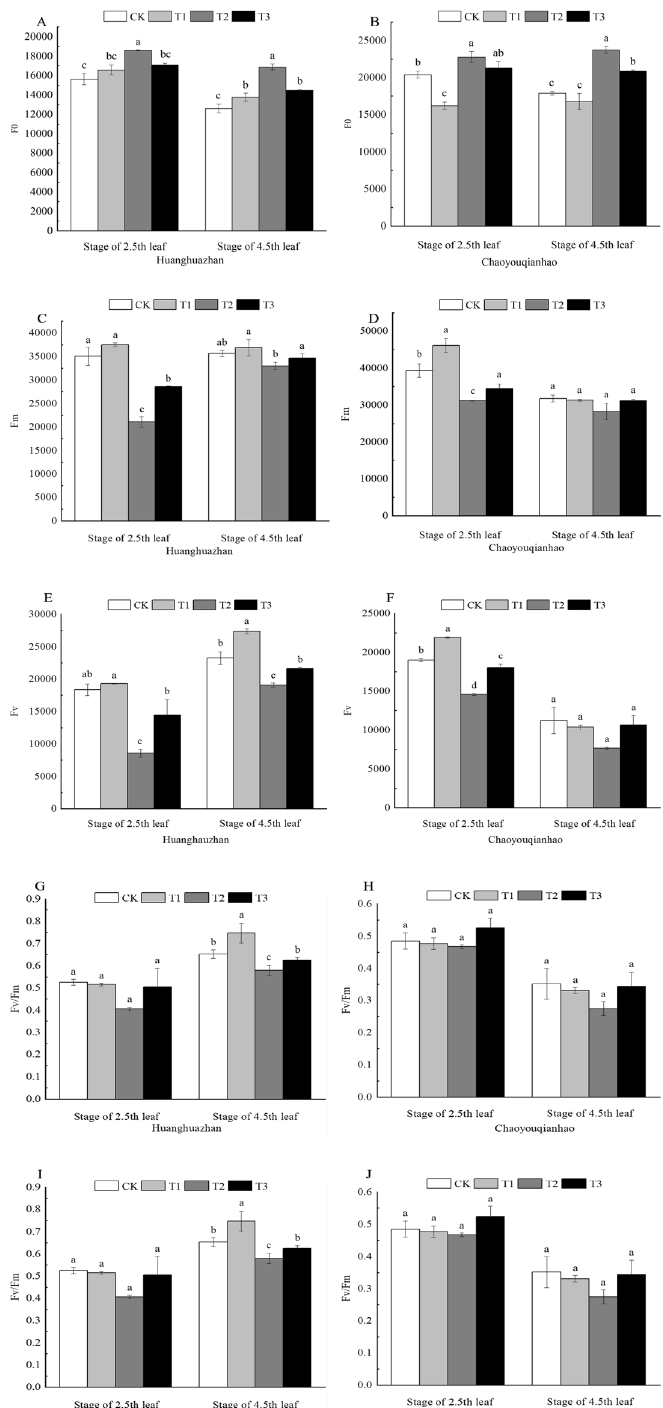
Figure 2. Effects of soaking with BR on chlorophyll fluorescence parameters of rice seedlings under salt stress. Different lowercase letters indicate significant differences at the P < 0.05 level. CK: soaking with distilled water + watering 0 g L −1 NaCl. T1: soaking with BR + watering 0 g L −1 NaCl. T2: soaking with distilled water + watering 3 g L −1 NaCl. T3: soaking with BR + watering 3 g L −1